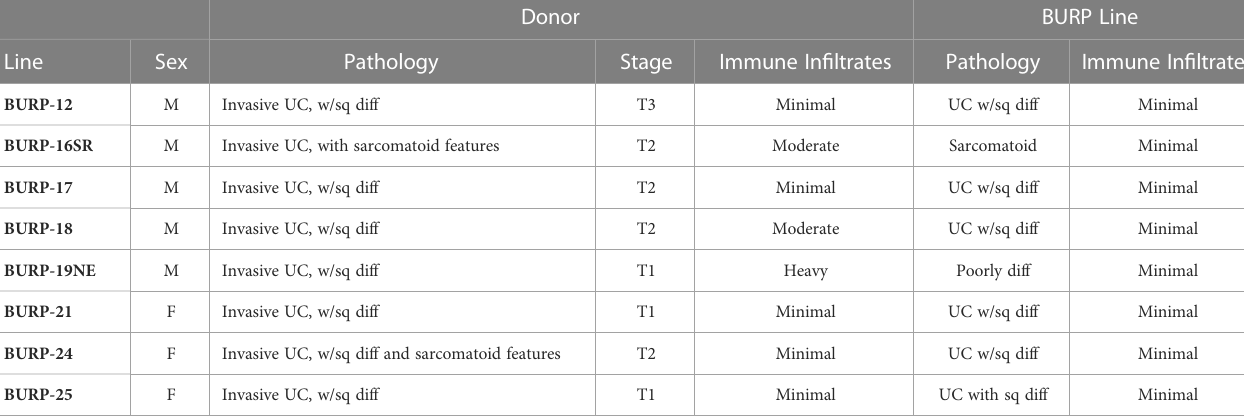
TABLE 2 Donor and BURP model sex, pathology, tumor stage, and immune in fi